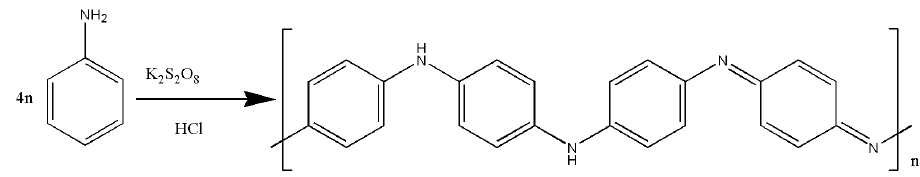
Figure 10. Emeraldine synthesis and structure.